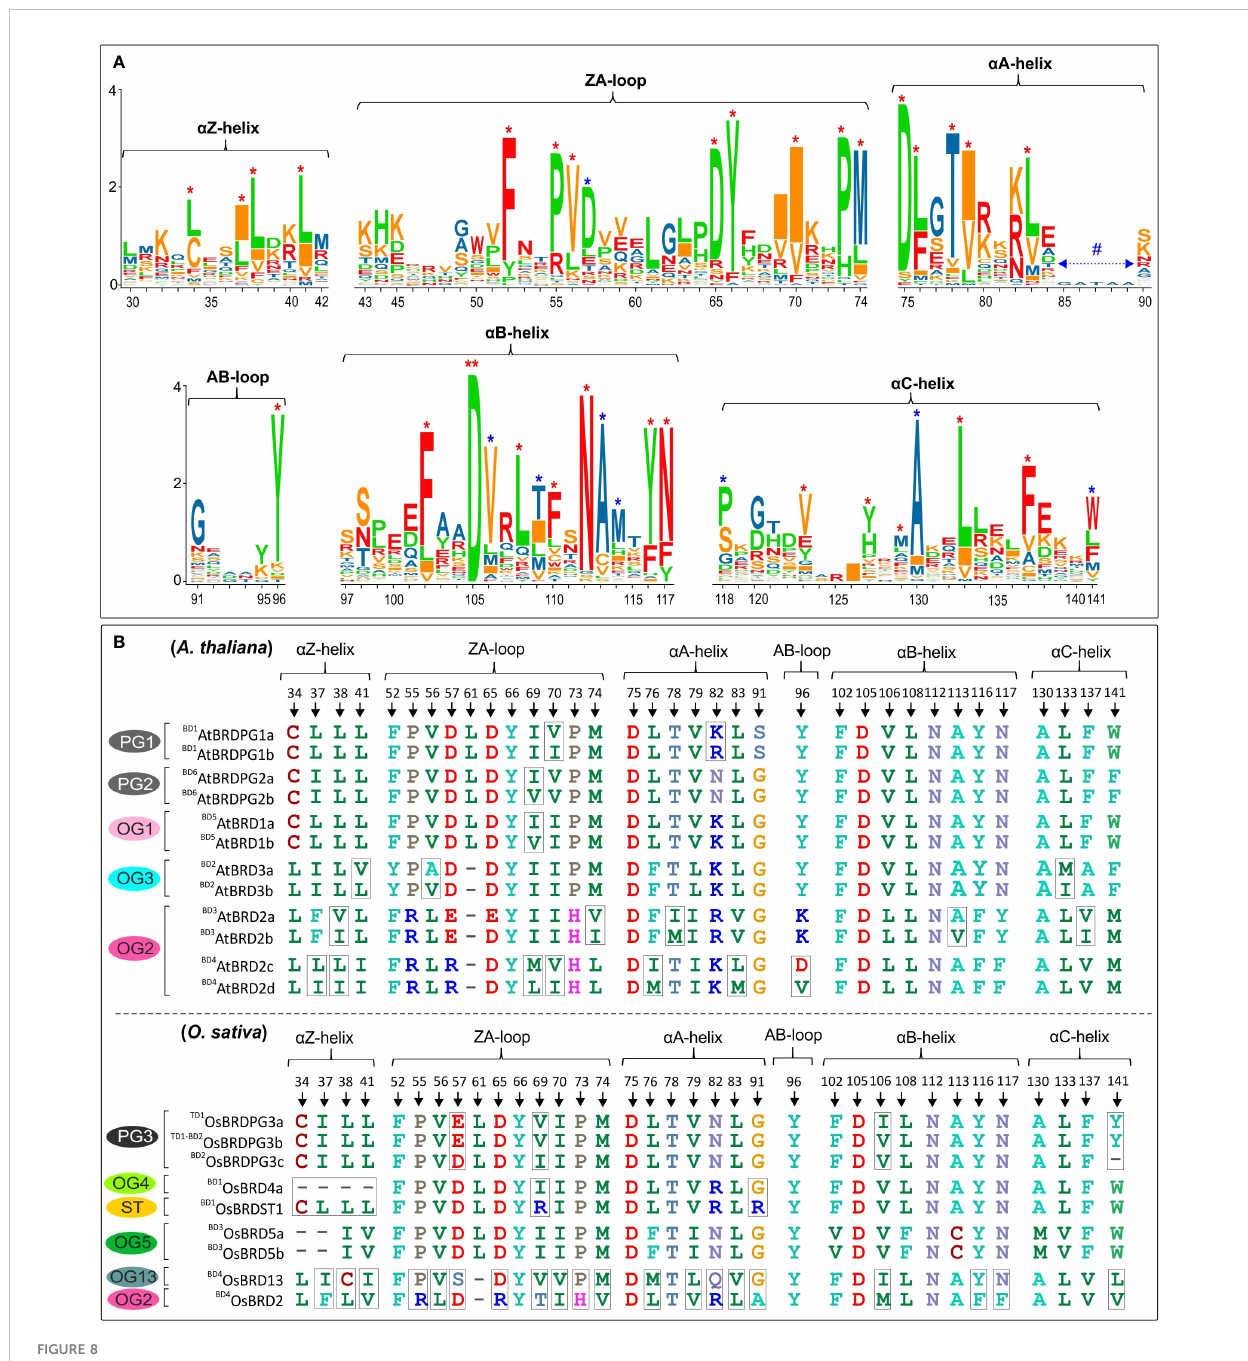
FIGURE 8 (A) Sequence logo analysis of the bromodomain (BRD)-region of 28 AtBRD and 22 OsBRD-homologs, indicating conserved residues in the key BRD- fold elements (helices: a Z, a A, a B, a C; loops: ZA, AB). ‘ * ’ indicates conserved sites (red ‘ * ’ : conserved residues also in human BRDs; blue ‘ * ’ : conserved sites in At- and OsBRDs), and ‘ ** ’ indicates an invariant residue, and # indicates region speci fi c to a single OsBrd (OsBRD2). Positions of amino acid residues (as per the alignment in Supplementary Figure 5) are indicated on the x-axis. (B) Comparison of conserved sites in key elements of BRD-fold among the duplicated BRDs of A. thaliana (top panel) and O. sativa (bottom panel). The association of duplicate-BRDs to different OGs/ PGs or ST category is indicated, designations ‘ BD ’ and ‘ TD ’ indicate type of duplication event, while the variations at key positions are indicated by rectangular